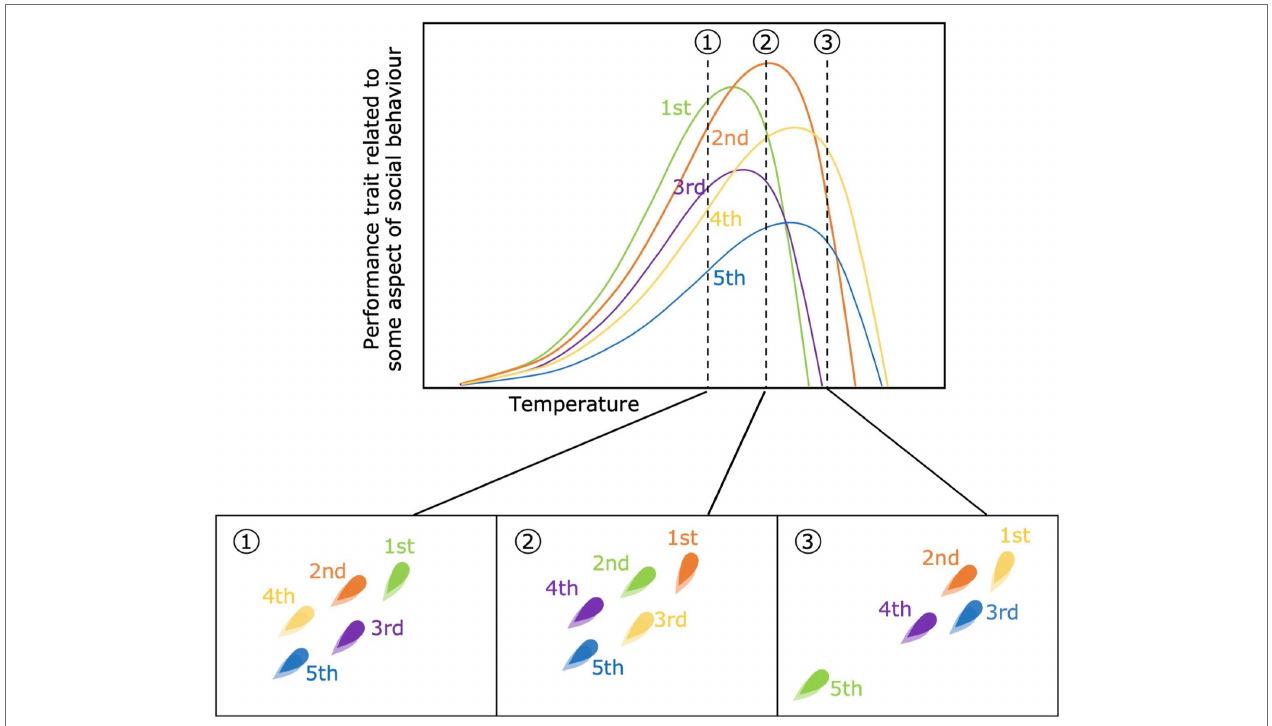
FIGURE 2 | Changes in the rank order of performance capacity across three different temperatures (top panel). Each color refers to an individual within the same social group. In the bottom panels the rank-assortment within the group is shown for each temperature (1, 2 and 3), assuming that higher-ranked individuals are positioned on the front of the group. For example, the green individual is the highest rank-individual (leader) at temperature 1, but a follower with 2nd rank position at temperature 2, and is no longer part of the group at temperature 3, given that the individual’s performance capacity decreases to 0 before temperature 3, while the rest of the groups has